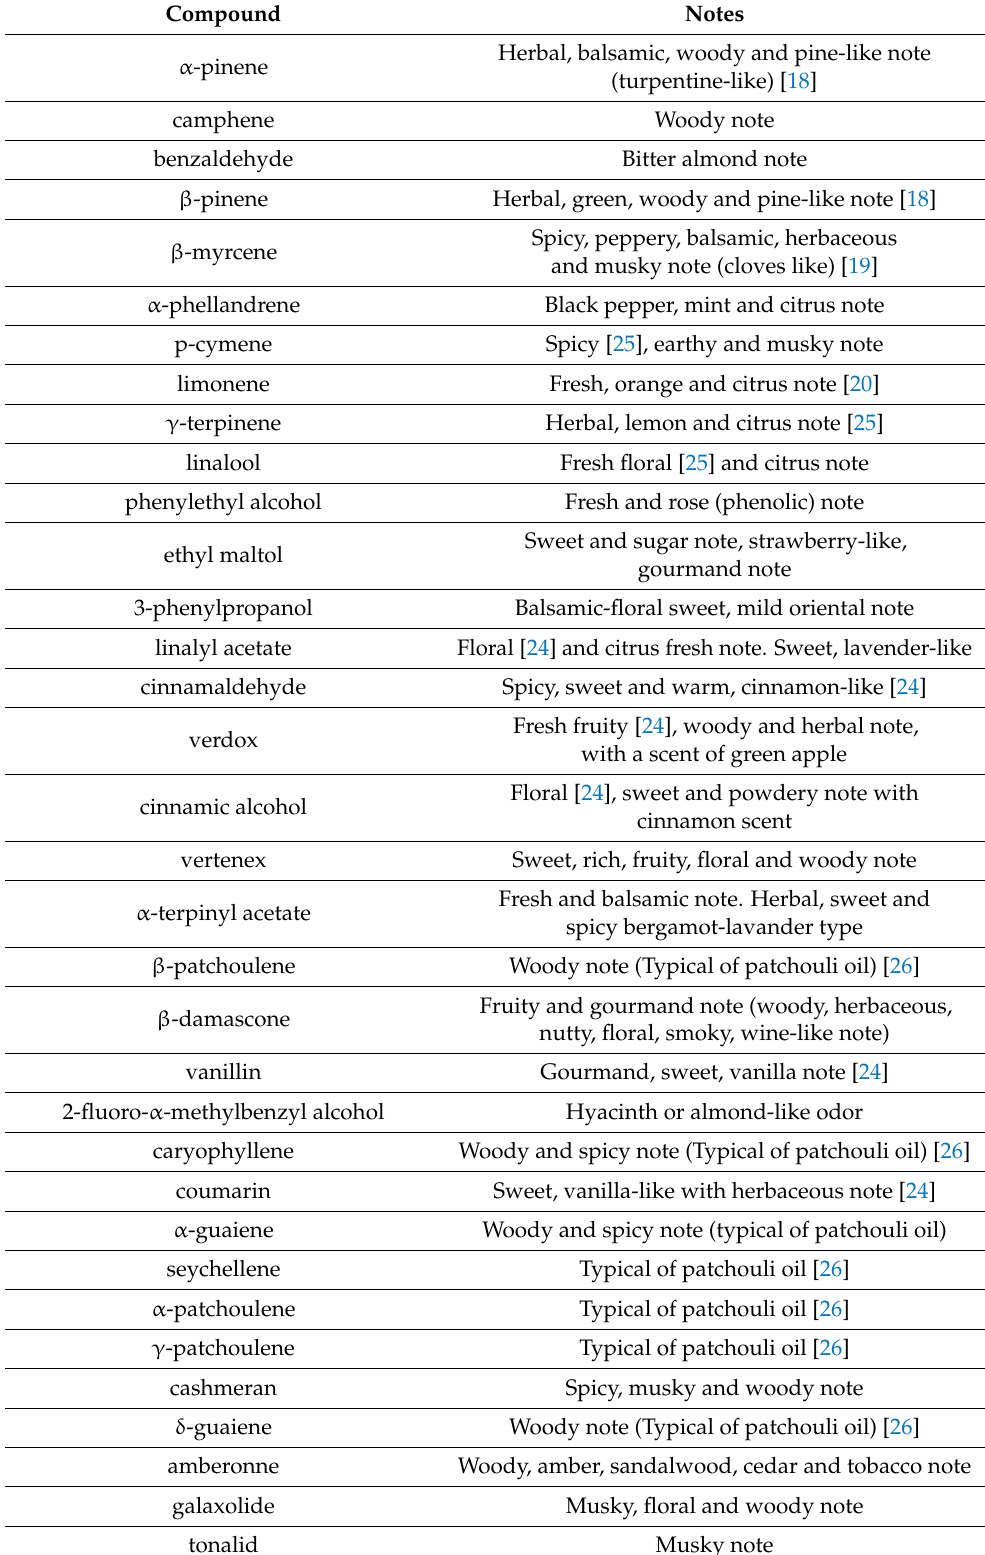
Table 6. List of odour compounds identified by the perfumer in the “Narguil é ” fragrance according to the compounds previously identified by